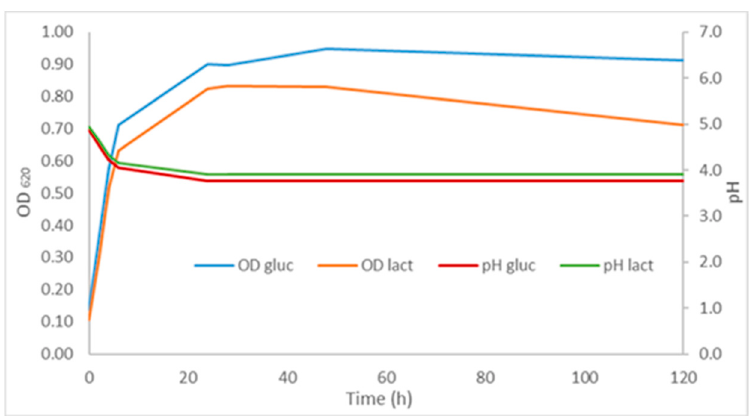
Figure 3. OD 620 and pH kinetics of L. mesenteroides. grown on glucose or lactose-supplemented Khardhenavis synthetic media (data are obtained from triplicated experiments).